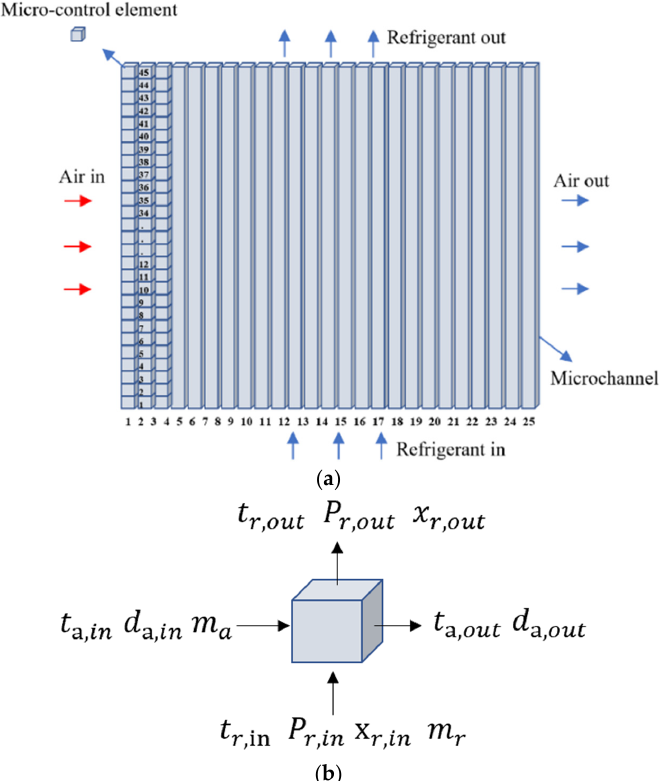
Figure 4. Schematic illustration of the microchannel evaporator model segment discretization: ( a ) segment discretization of a microchannel heat exchanger flat tube; ( b ) micro-control element. The numerical simulation flowchart of a microchannel tube is illustrated in Figure 5. Firstly,the mass, momentum, and energy equations on the refrigerant side and the energy equation on the air side for each microchannel were discretized. Next, the unknown parameters, such as the mass flow rate in each microchannel, the refrigerant state and the temperature distribution in the adjacent microchannels were assumed prior to calculating the numerical solution. Then, using the input parameters, such as the input air temperature, humidity, the input refrigerant parameters and the assumed parameters mentioned above, the numerical solution for the 1st microchannel was carried out from the micro-control element at the microchannel inlet to the micro-control element at the microchannel outlet. When the numerical solution for the 1st microchannel was completed, the output air temperature for each micro-control element was used as the input air temperature for the micro-control element of the second microchannel. In this way, the numerical solutions for the microchannels in the flat tubes were completed one by one.